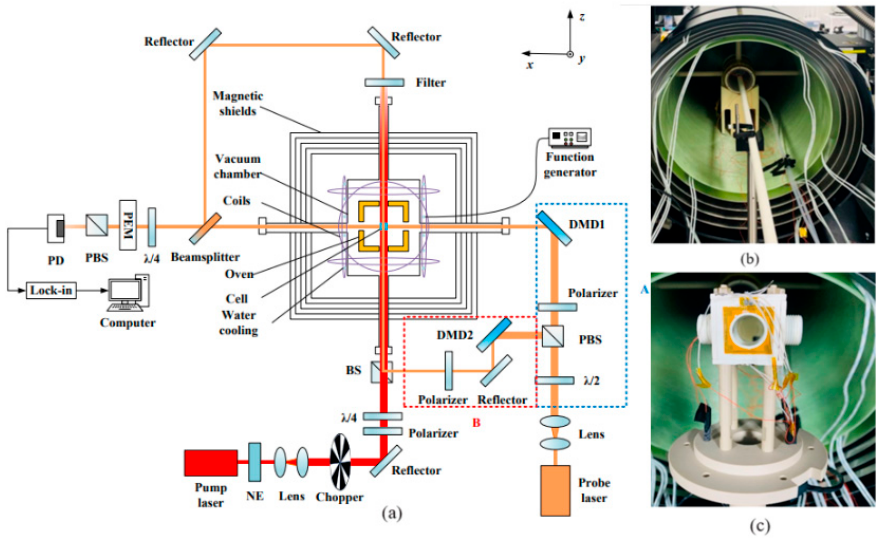
Figure 2. ( a ) Experimental diagram of the SERF magnetometer. NE: noise eater; PEM: photo elastic modulator; GT: Glan–Taylor polarizer; PD: photodetector. ( b ) Photographs of the five-layer magnetic shielding and nonmagnetic vacuum system. ( c ) Photographs of the nonmagnetic electric heating system and the square cell in the center.